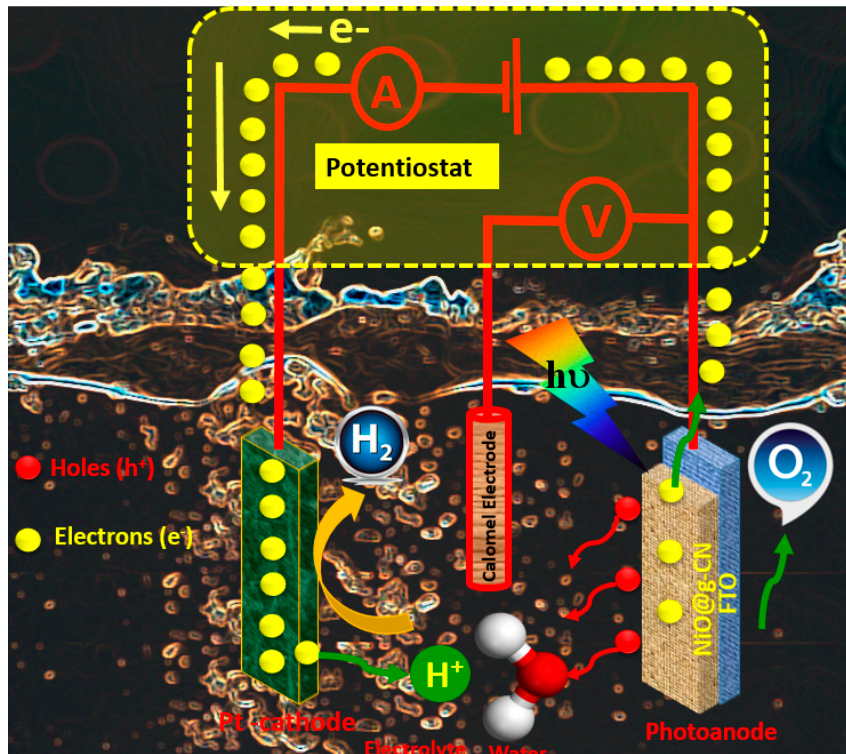
Figure 10. Schematic sketch of proposed photoelectrochemical working mechanism of the NiO@g-CN nanocomposite photoanode for water splitting.